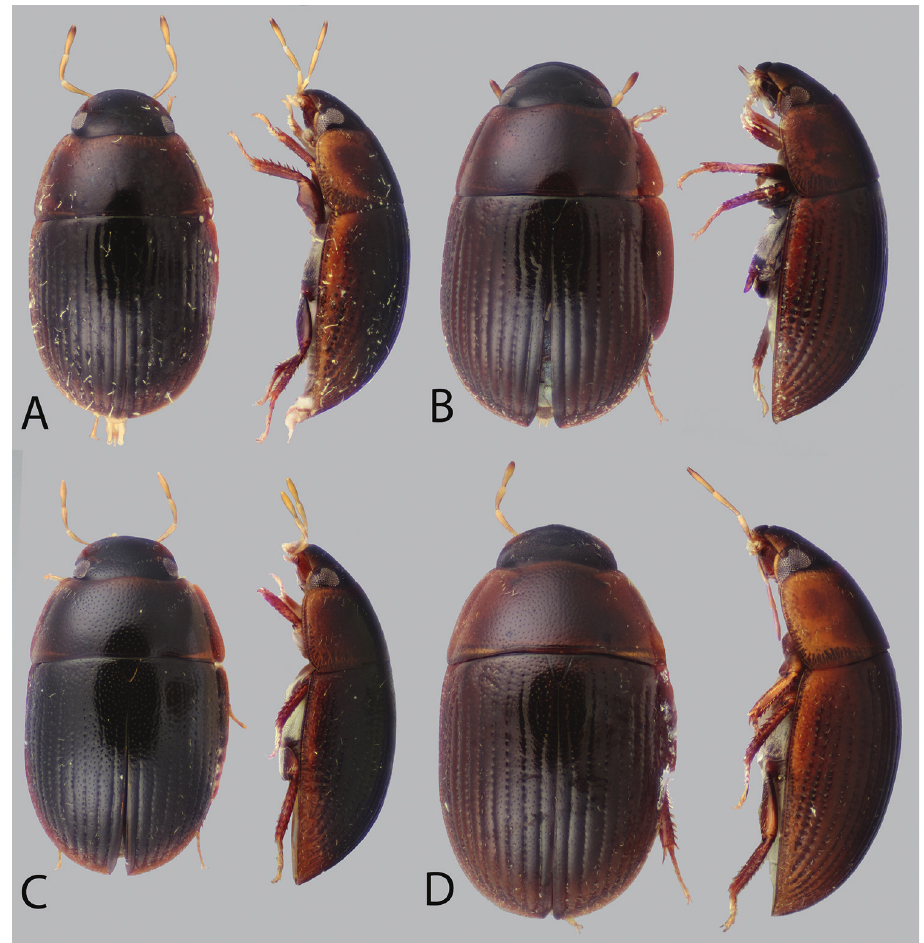
Figure 2. Dorsal and lateral habitus of Tobochares spp. A T. sulcatus B T. striatus C T. sipaliwini D T. kusad sp.